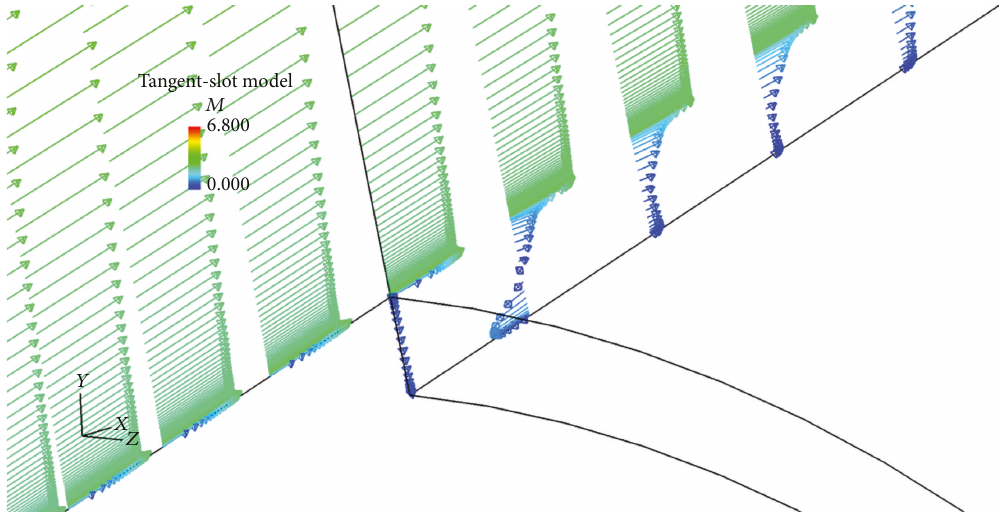
Figure 21: Velocity vectors near the slot region, no jet, Re = 4 3 × 10 6 , α = 0 0 ° , M = 6 .